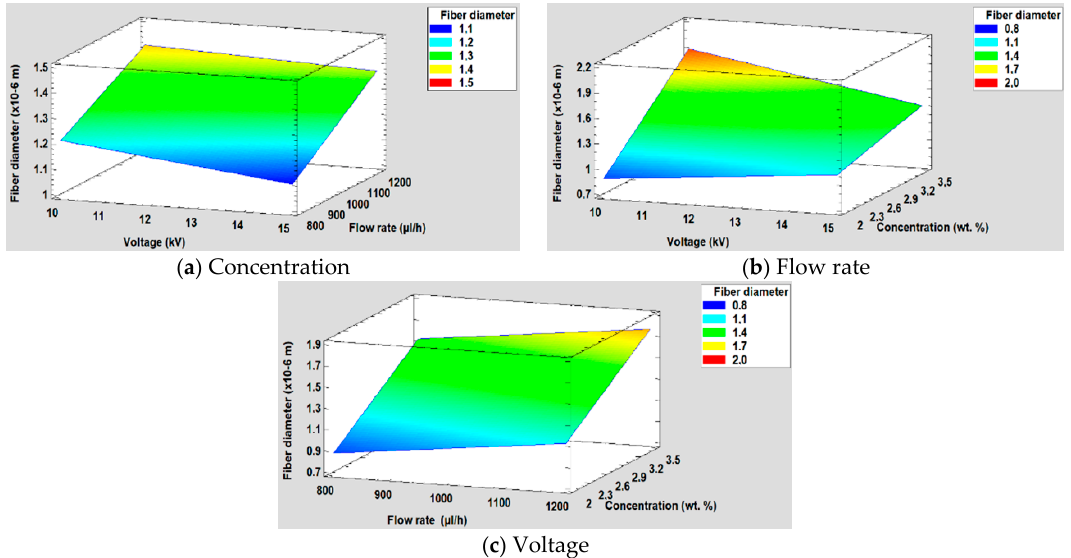
Figure 10. ( a ) Concentration, ( b ) Flow rate and ( c ) Voltage surface response in the average fiber diameter.